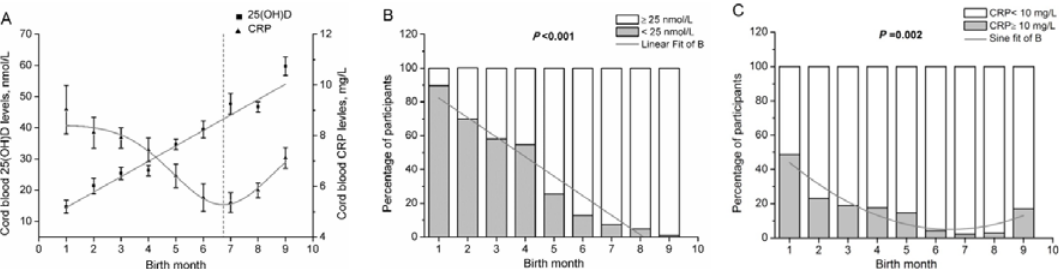
Figure 3. Seasonality of cord blood 25(OH)D and CRP ( n = 1491). The trends of cord blood 25(OH)D and CRP levels across birth month were assessed by fitting the data to the best-fitting linear and sinusoidal model, respectively ( A ). The proportions of cord blood 25(OH)D <25.0 nmol/L ( A ) and CRP ≥10 mg/L ( B ) across birth month were assessed by linear regression model and nonlinear regression with sine function, respectively. Bars represent mean and 95% CI of the mean ( A ). The solid grey line denotes the fit of the regression model ( A – C ). The vertical lines denote the birth month of fitted minimum concentrations of CRP ( A ).